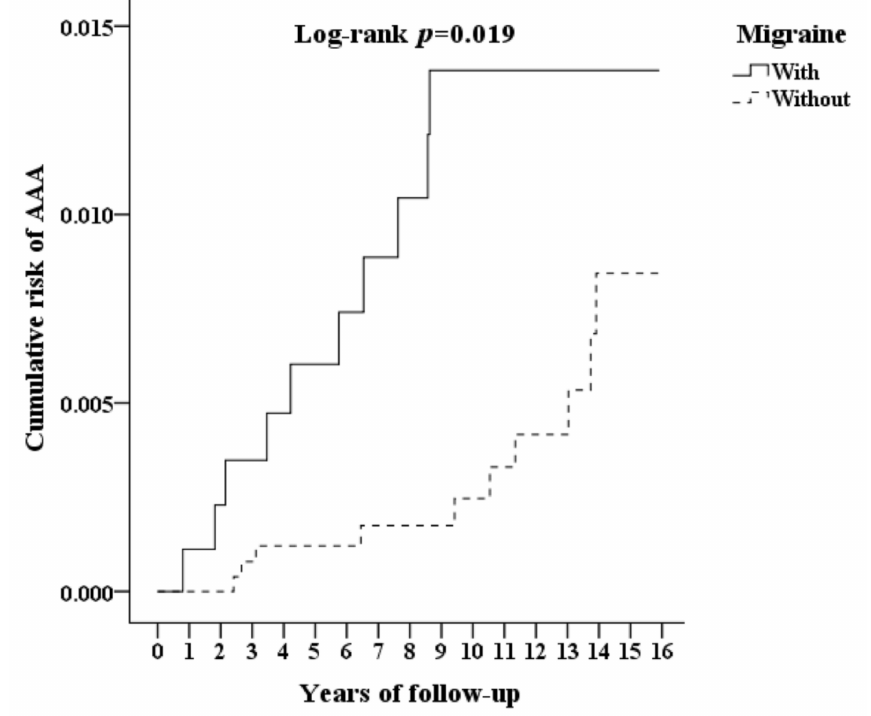
Figure 2. Kaplan–Meier curve for the cumulative risk of abdominal aortic aneurysm due to migraine. Table 2. Incidence rates of abdominal aortic aneurysm and other characteristics in the enrolled study participants at the end of the 15-year follow-up